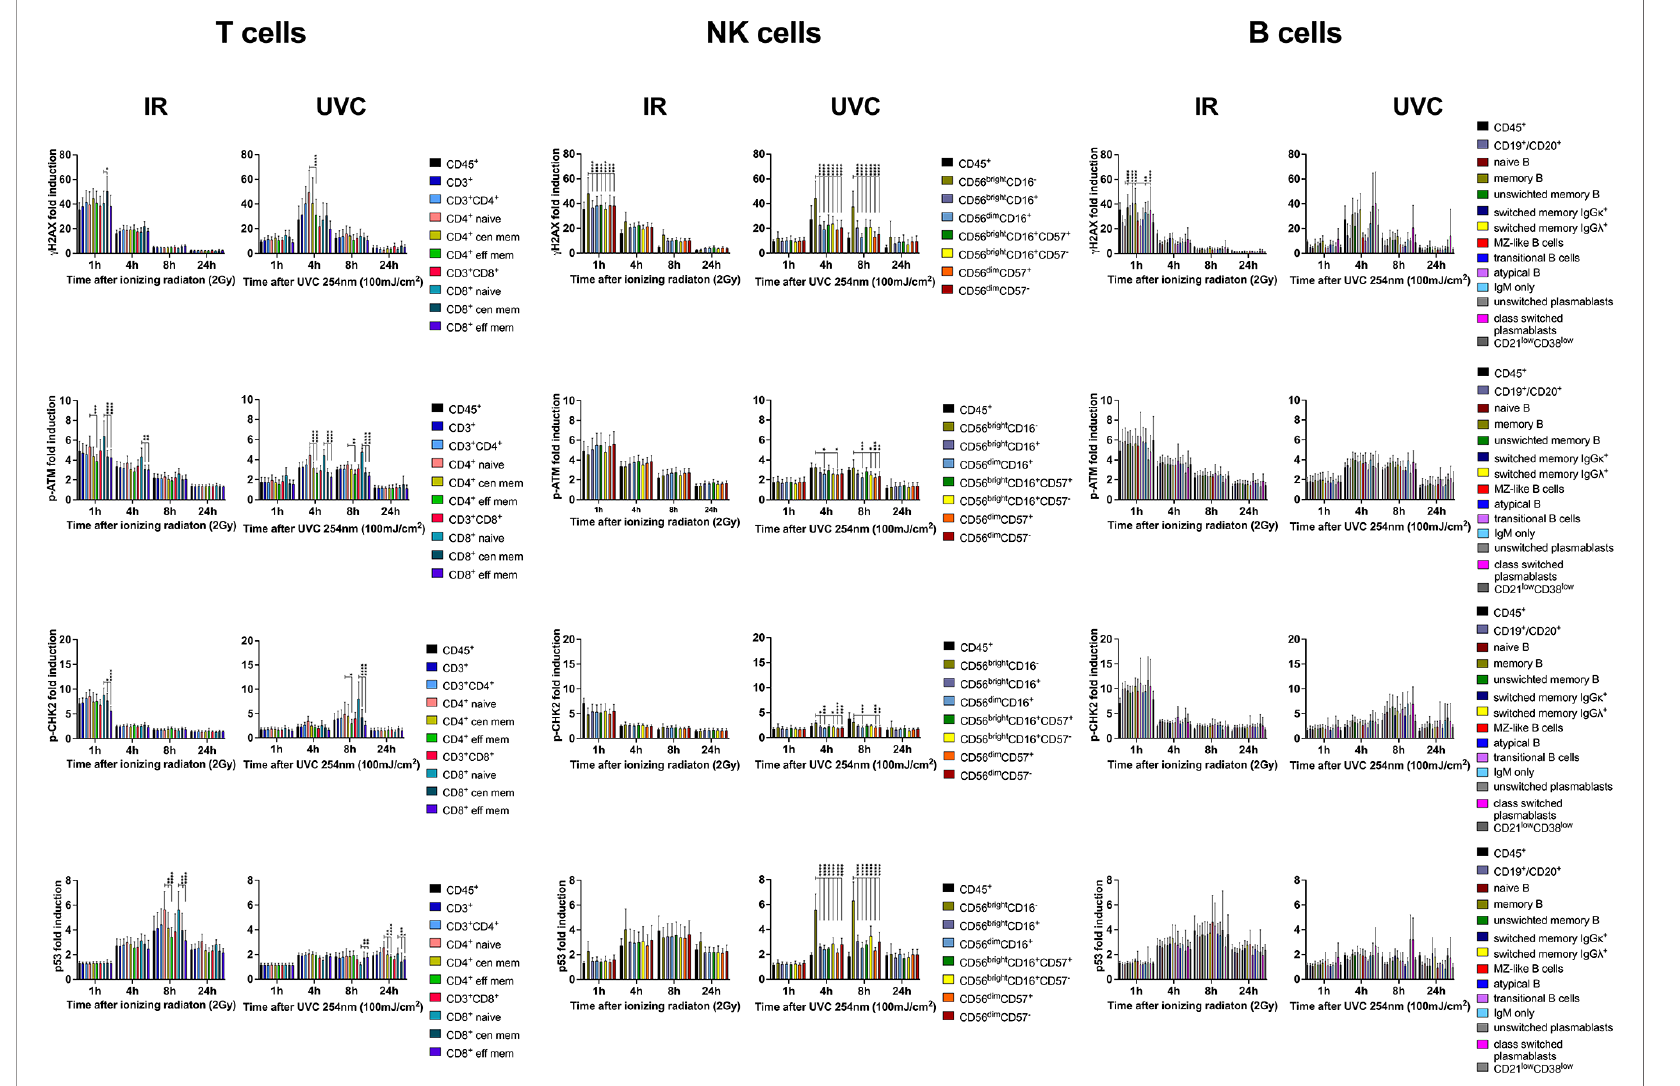
FIGURE 8 | DDR of PBMCs to IR is differential to DDR induced by UVC. PBMCs obtained from 8 healthy donors were irradiated with 2Gy or 100mJ/m 2 UVC, respectively. Surface markers of lymphocyte subsets and intranuclear DDR biomarkers were analyzed by mass cytometry. Fold inductions of g H2AX, p-ATM, p-CHK2, and p53 were calculated in CD45 + lymphocyte subsets, based on mean fl uorescence intensities normalized on unirradiated samples. Bars indicate mean values of fold induction; error bars represent standard deviations. Signi fi cance is shown for naïve T and B cell subsets compared to memory subsets, and immature CD56 bright CD16 - to mature CD56 dim CD16 + NK lymphocytes (*p ≤ 0.05, **p ≤ 0.01, ***p ≤ 0.001, ****p ≤